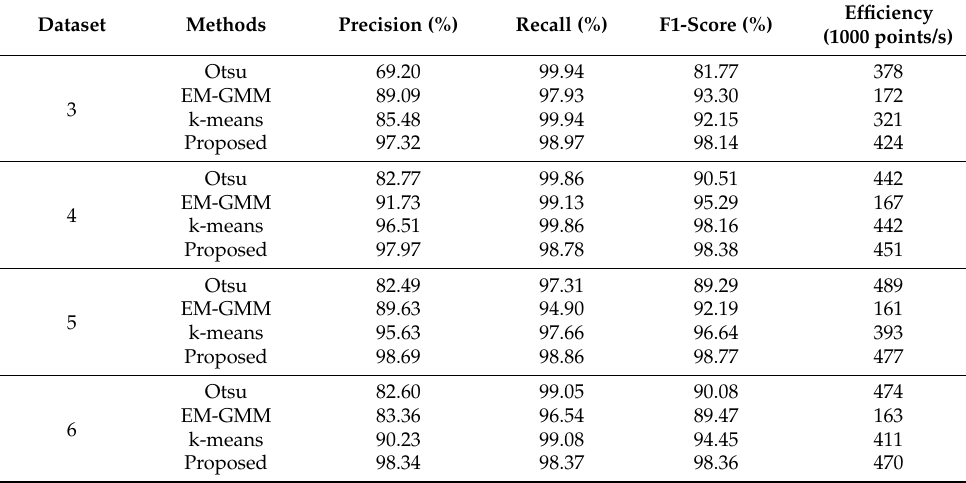
Table 5. Performance comparison of four segmentation methods (Otsu, EM-GMM, k-means, and the proposed) using Marco datasets # 3, 4, 5, and 6.